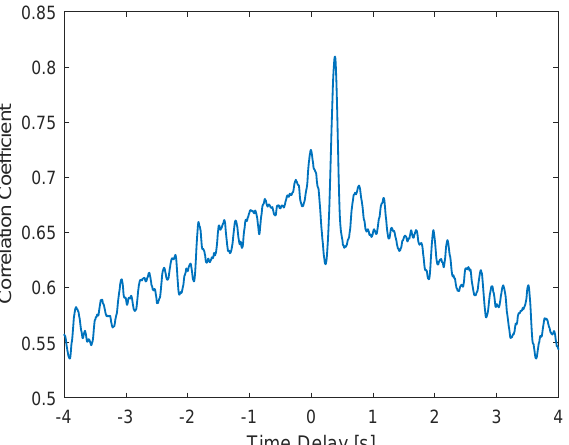
Figure 17. Cross-correlation coefficient between the camera and wire-mesh sensor volumetric frac- tions of air for a liquid flow rate of 160 L/min and an air flow rate of 170